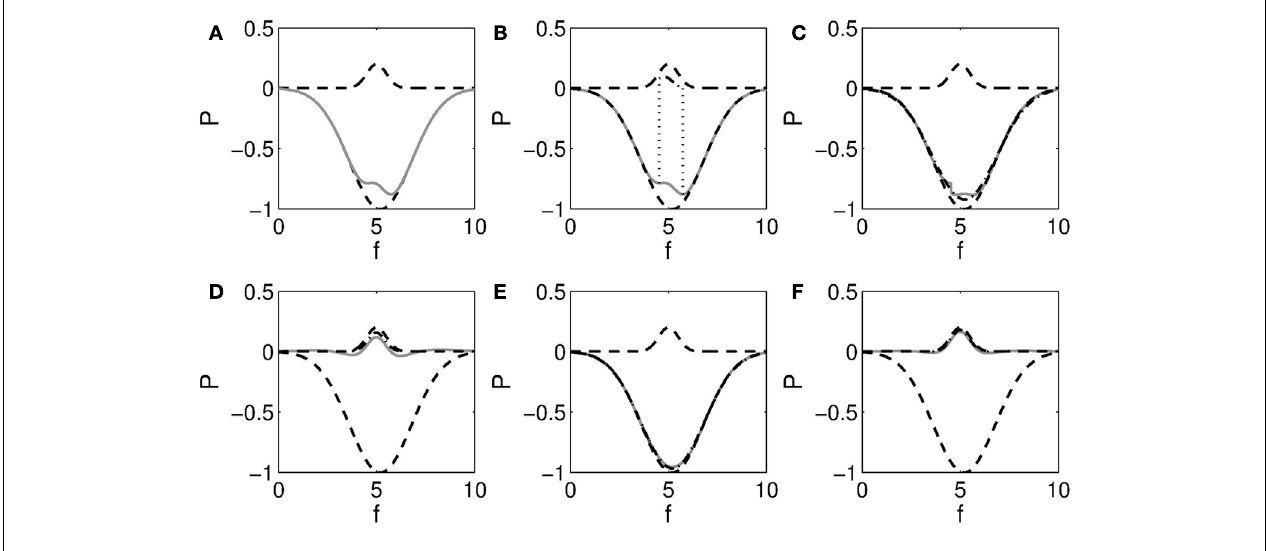
FIGURE 5 | Illustration of recursive fitting of overlapping peak and trough. (A) Shows a Gaussian peak at f = 5 and trough at f = 5.2 (dashed), and their sum in gray. A small peak remains visible over the range shown in (B) . Fitting this peak leaves the residual shown in gray in